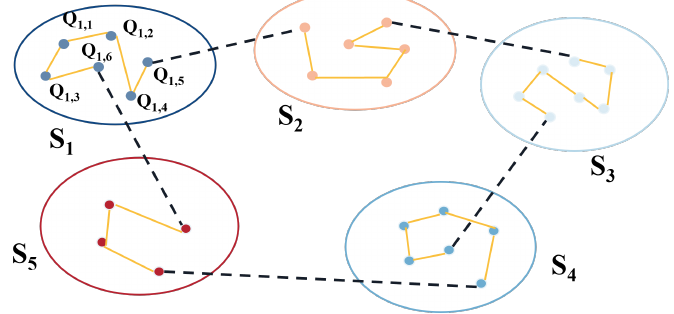
Figure 2. Schematic diagram of GTSP problem.